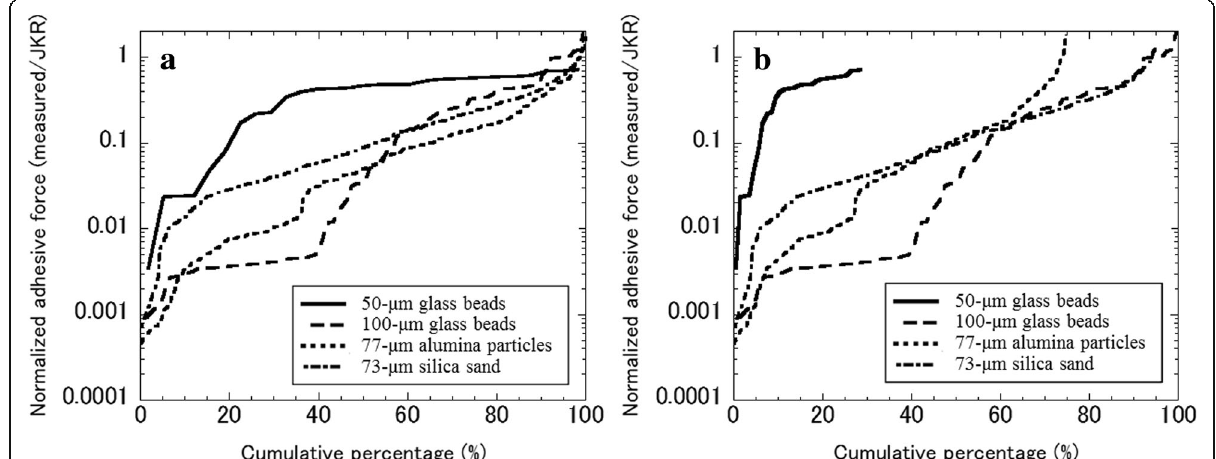
Fig. 6 Measurement results of the adhesive force. The ratio of the measurement value of the adhesive force using a Petri dish to the theoretical reference value against the cumulative percentage. Solid, dashed, dotted, and dashed and dotted lines show the 50 μ m glass beads, 100 μ m glass beads, alumina particles, and silica sand, respectively. a The percentage reflects the number of detached particles/total number of detached particles ratio. b The percentage reflects the number of detached particles/total number of observed particles ratio